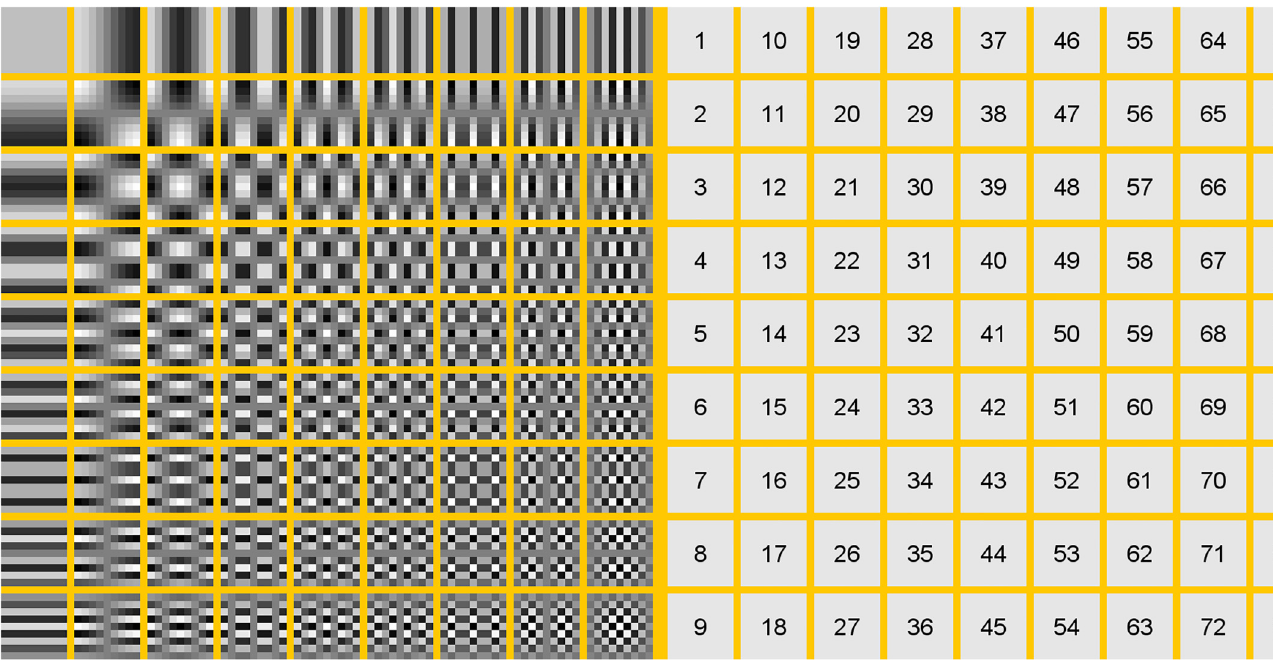
Fig 2. Visualization of DCT coefficients for n = 9 (left) and corresponding index numbers (right). Negative values are depicted in black or dark gray and positive coefficients are shown in white or light gray.